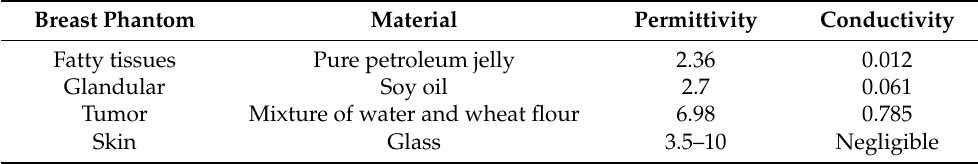
Table 2. Dielectric properties of breast phantom and tumor [25,28]. Breast Phantom Material Permittivity Conductivity Fatty tissues Pure petroleum jelly 2.36 0.012 Glandular Soy oil 2.7 0.061 Tumor Mixture of water and wheat flour 6.98 0.785 Skin Glass 3.5–10 Negligible